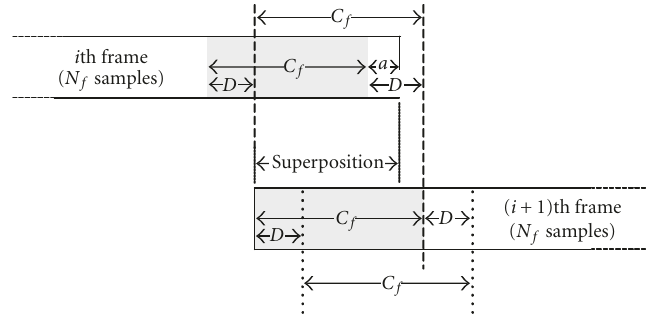
Figure 4: Superposition between the frames.